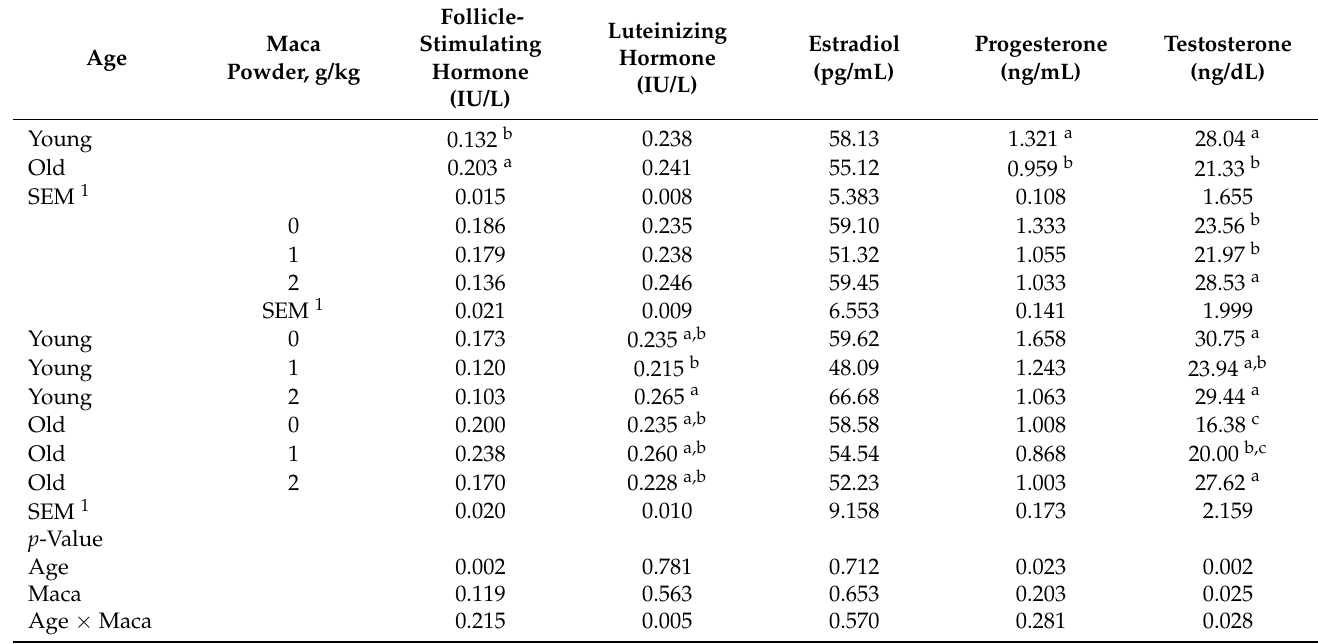
Table 5. Effects of Maca powder supplementation in diets of laying quails at different ages serum hormone